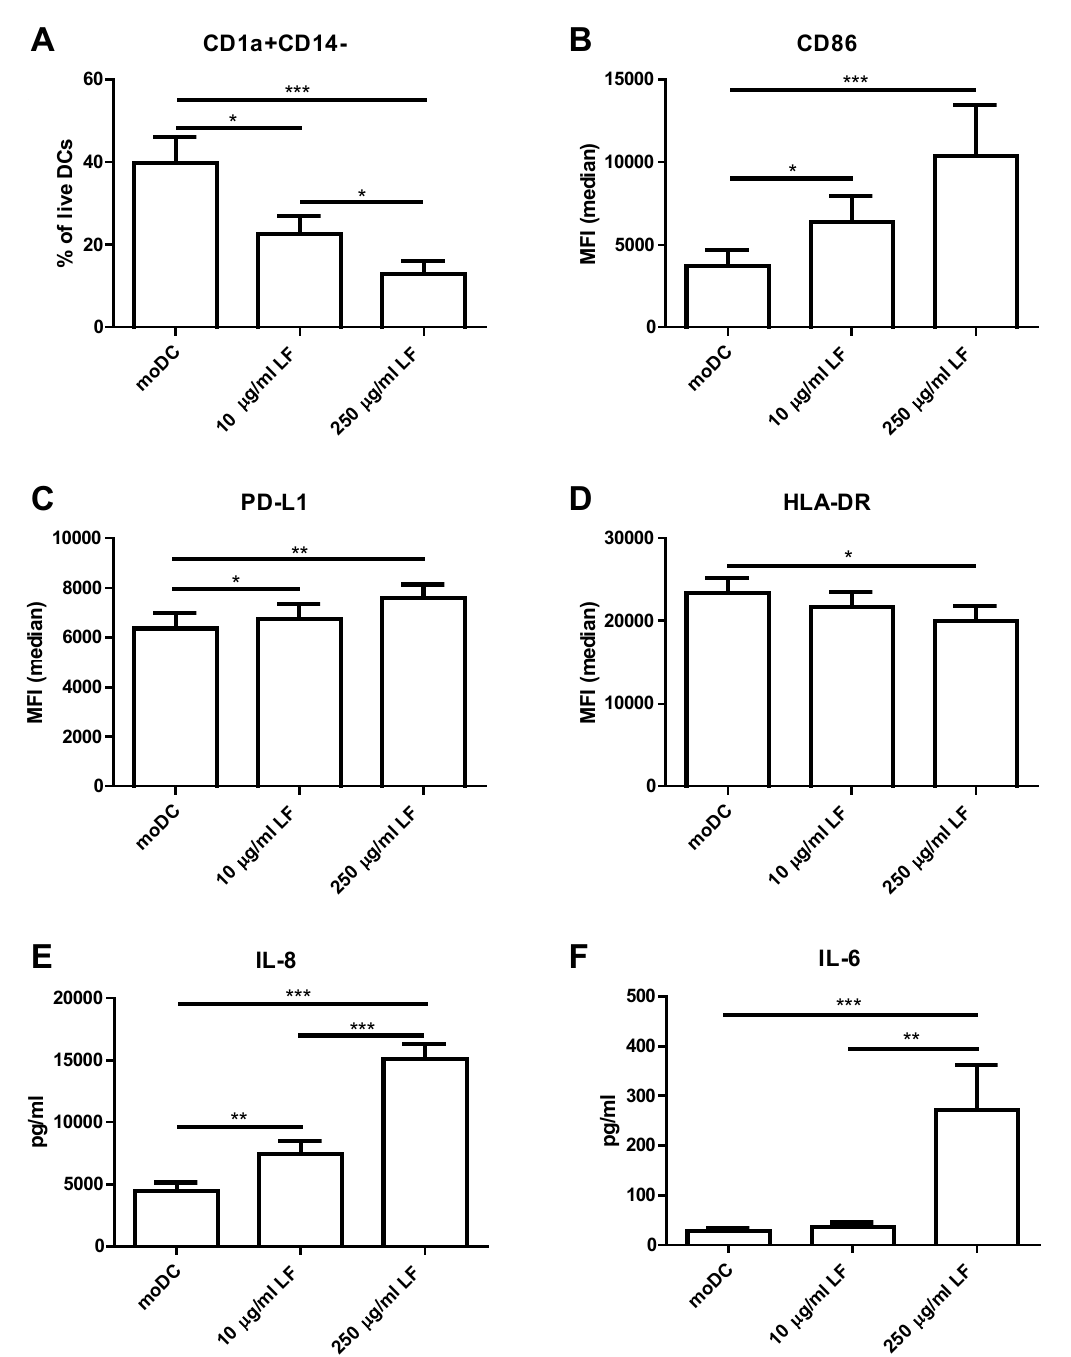
Figure 1. LF modulates DC differentiation. Monocytes were differentiated into moDC by culturing them for six days in the presence of IL-4 and GM-CSF with or without LF (10 or 250 µg/mL LF). ( A ) The percentage CD1a+CD14 − DC and the median fluorescent intensity (MFI) of ( B ) CD86, ( C ) PD-L1 and ( D ) HLA-DR was shown. The production of ( E ) IL-8 and ( F ) IL-6 was measured in the supernatant by CBA. The mean ± SEM of four independent experiments with 12 different donors was shown. Significance is indicated by *** = p < 0.001, ** = p < 0.01 and * = p < 0.05.